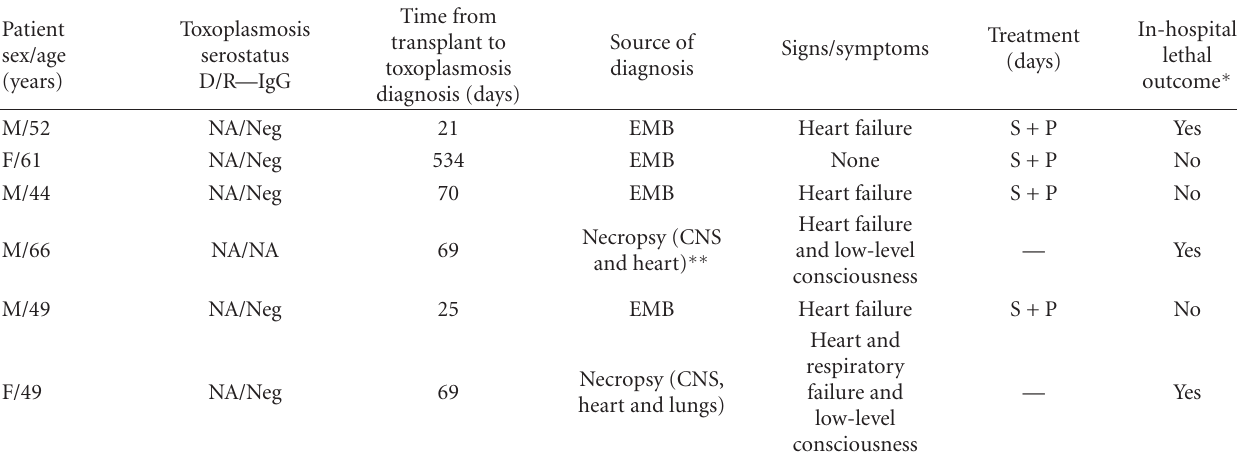
Table 1: Clinical and laboratorial data for six cases of Toxoplasma infection after cardiac transplantation without toxoplasmosis prophylaxis occurring before